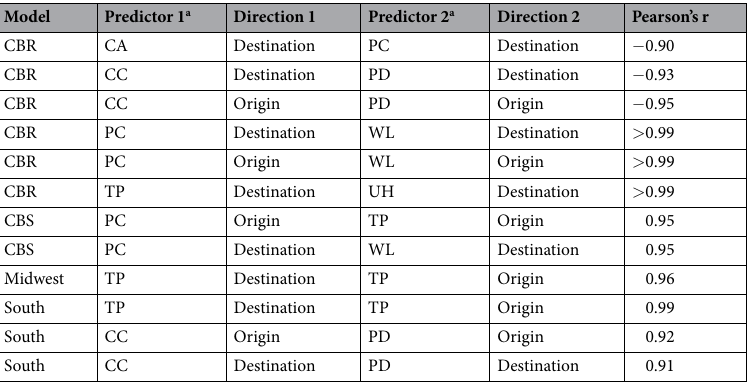
Table 1. Predictor combinations where |Pearson’s r| > 0.9. a (CA) Corvidae counts; (CC) case counts; (PC) precipitation; (PD) population density; (TP) temperature; (UH) unvaccinated horses; (WL)